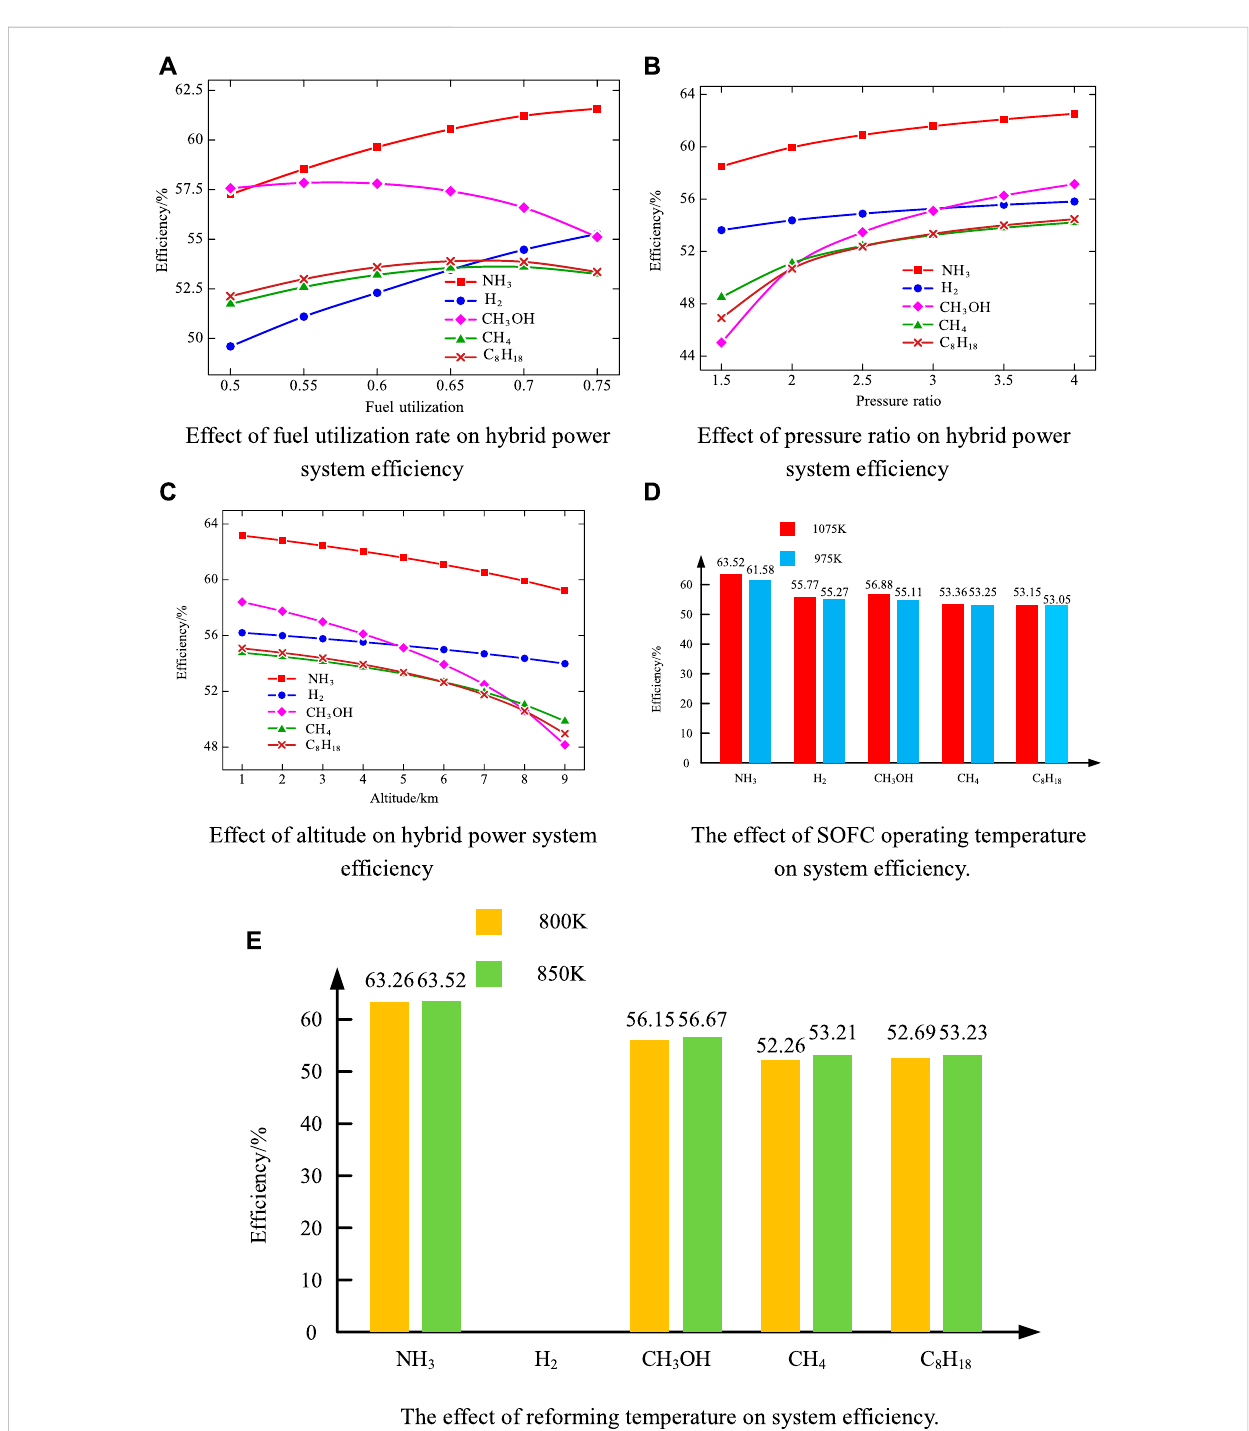
FIGURE 9 Effect of parameters on system ef fi ciency. (A) Effect of fuel utilization rate on hybrid power system ef fi ciency. (B) Effect of pressure ratio on hybrid power system ef fi ciency. (C) Effect of altitude on hybrid power system ef fi ciency. (D) The effect of SOFC operating temperature on system ef fi ciency. (E) The effect of reforming temperature on system ef fi